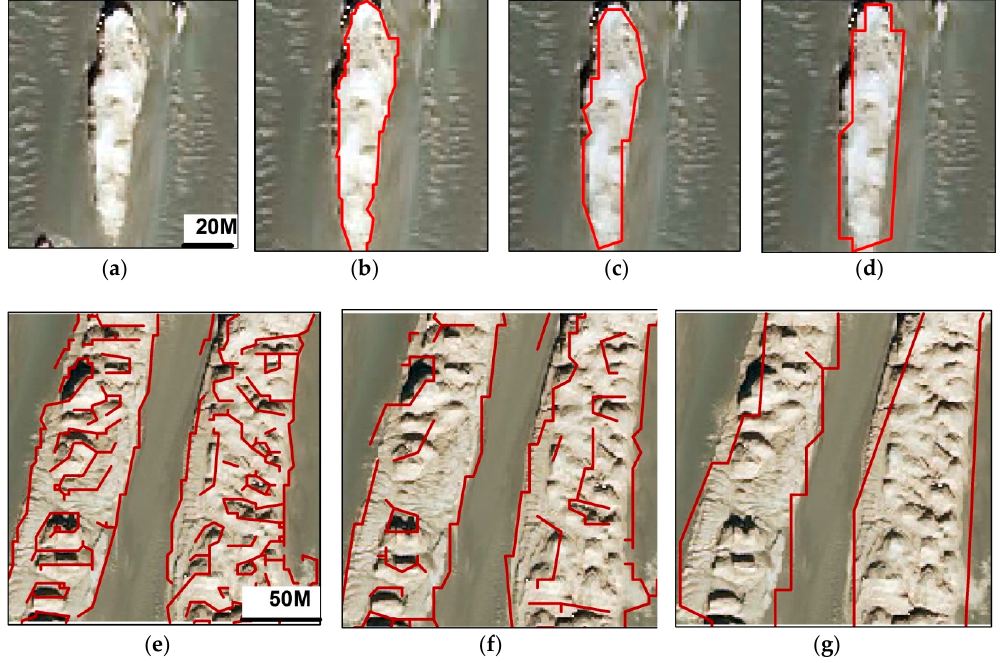
Figure 8. The results of CED method with different spatial resolutions: ( a ) The original very high-resolution image subset in Google Earth, ( b ) 1.19 m,( c ) 3 m, ( d ) 5 m,( e ) 3 m, ( f ) 5 m, and ( g ) 10 m.